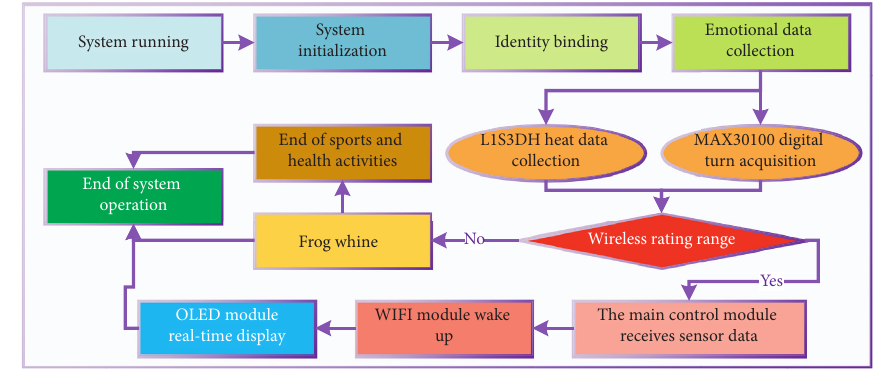
Figure 3: System workflow